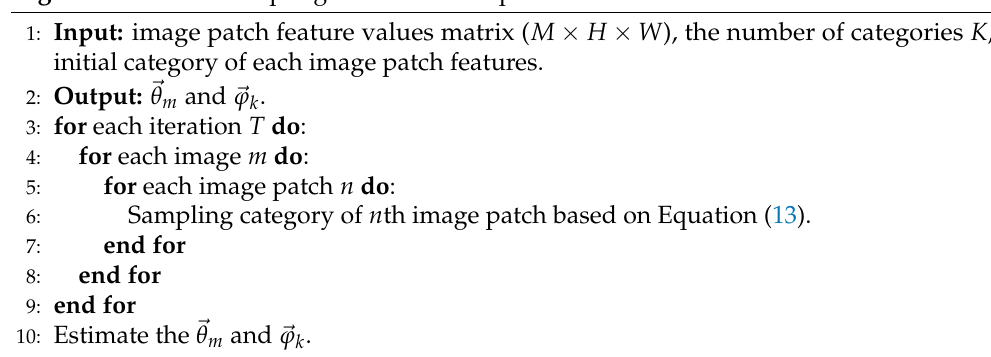
Algorithm 2 Gibbs sampling for LDA with spatial coherence